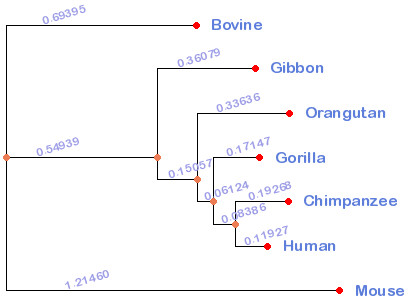
A phylogeny drawn by PHY·FI.